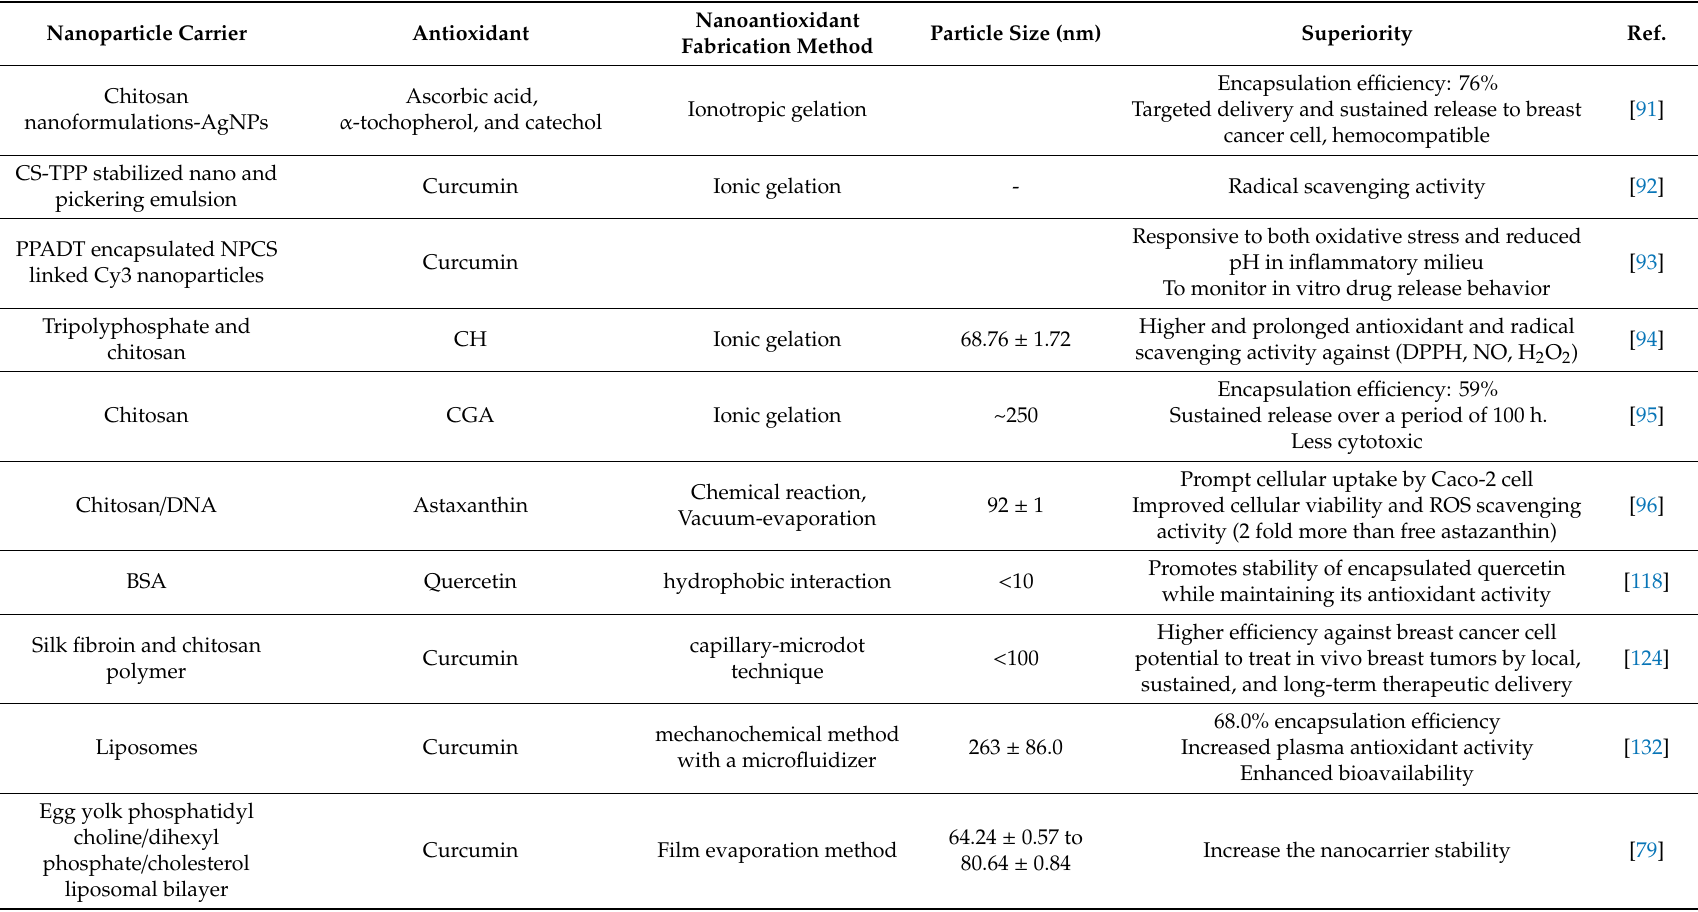
Table 2. Nanoparticles mediated antioxidants encapsulation and